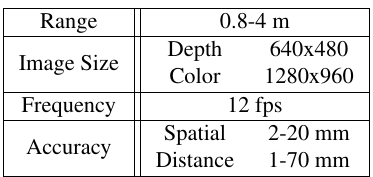
Figure 1: The developed mobile data acquisition system with multiple RGB-D and DSLR cameras. Table 1: Basic parameters of Kinect